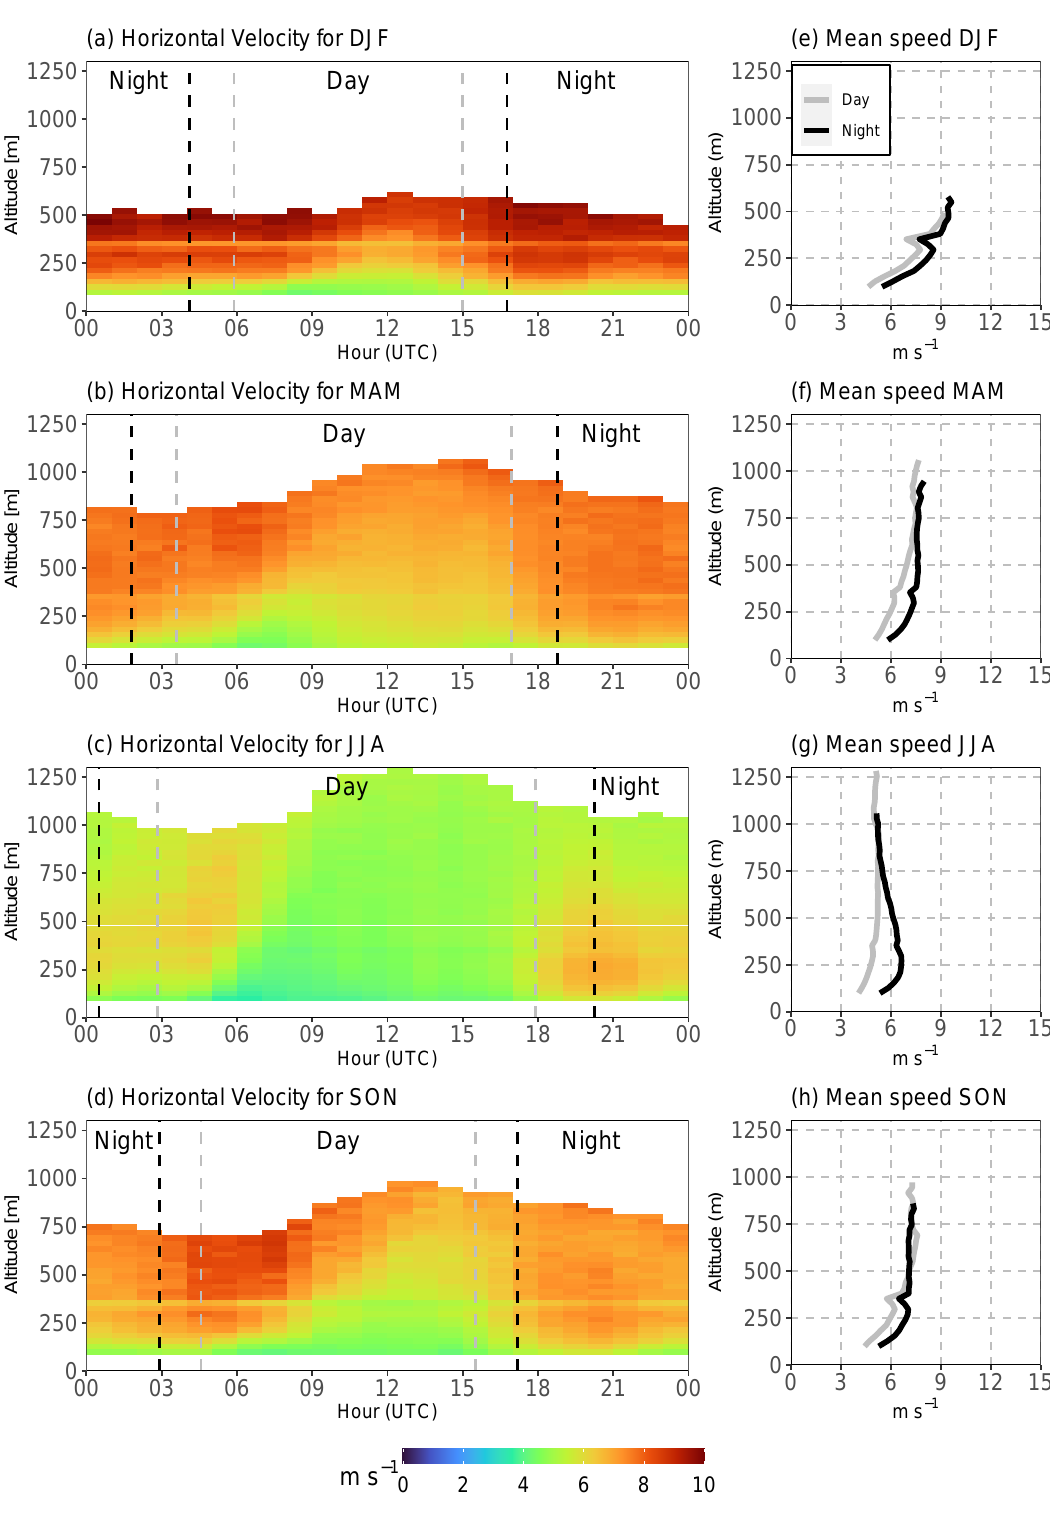
pronounced in spring compared to the other seasons, being related to a larger temperature difference between day and night. The DWL distribution of diurnal wind direction fits well with ERA5 climatology (Figure 8b,f).